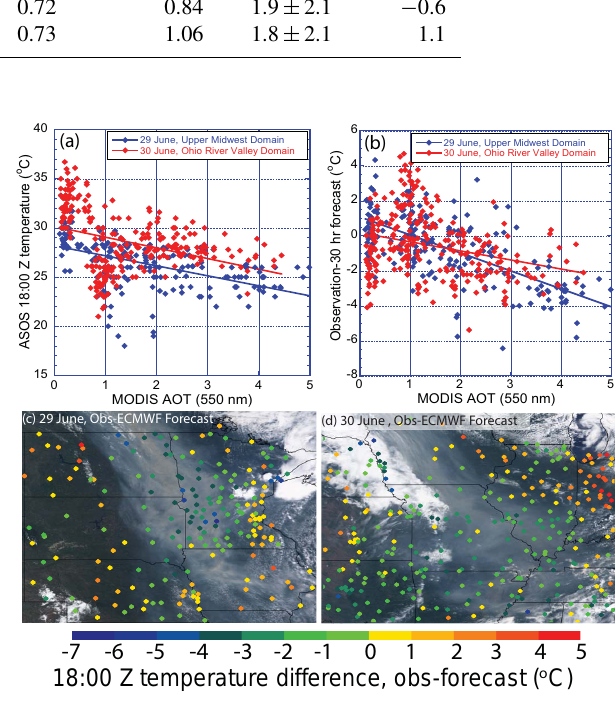
Figure 7. (a) The observed near-surface air temperature and (b) the differences in observed and ECMWF 30h forecasted near-surface air temperature ( (cid:49)T 30h ) as a function of MODIS DT τ 550 for both the 29 June and the 30 June case. (c) RGB image over the upper Midwest on 29 June 2015, constructed using Terra MODIS level 1B data. (cid:49)T 30h values from each ASOS station are overplotted on Fig. 7c. (d) Similar to panel (c) but over the Ohio River Valley on 30 June